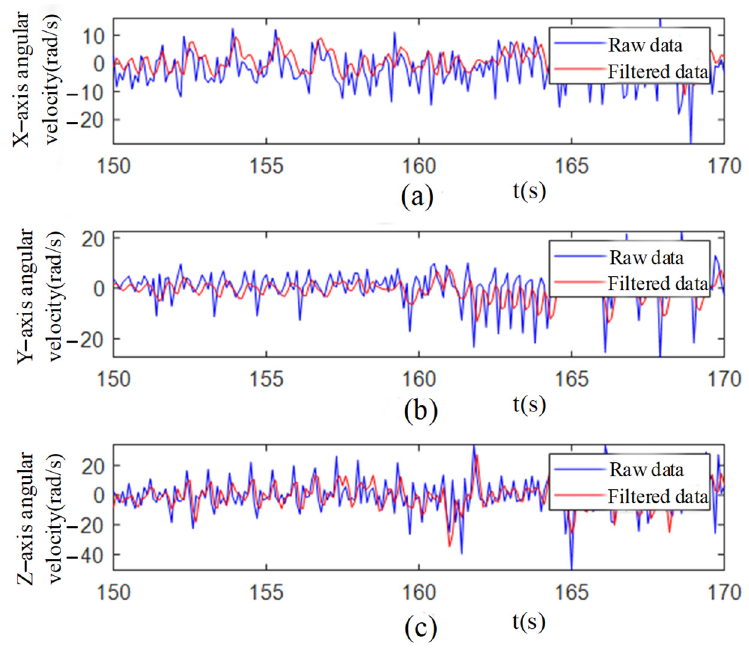
Figure 6. Comparison diagram of accelerometer signal before and after calibration and filtering. ( a ) Specific acceleration in X-axis. ( b ) Specific acceleration in Y-axis. ( c ) Specific acceleration in Z- axis.